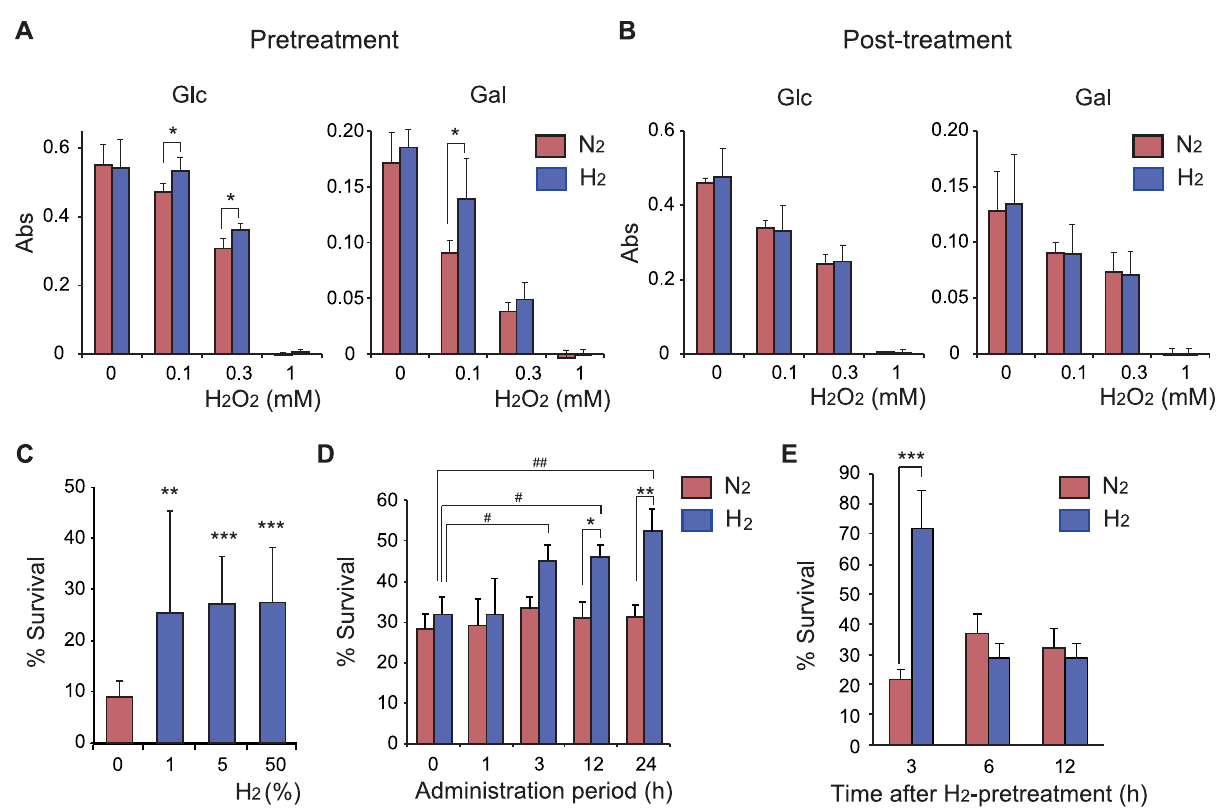
Fig 2. Protective effect of H 2 pretreatment against H 2 O 2 -induced cell death. (A) For pretreatment with mixed gas, SH-SY5Y cells were incubatedin culture medium containingeither Glc or Gal under N 2 - or H 2 -mixed gas for 18 h. Immediately after the end of exposureto the mixed gas, the medium was replaced with fresh medium containingthe indicatedconcentration of H 2 O 2 . Cells were further incubatedin a conventional CO 2 incubatorfor 18 h. (B) For post-treatment with mixed gases, culture medium containingeither Glc or Gal was replaced with fresh medium containingthe indicatedconcentration of H 2 O 2 . Cells were further incubatedunder an appropriate mixed gas. After the final incubation,cell viability was estimated by a modified3-(4,5-dimethylthiazol-2-yl)-2,5-diphenyltetrasodium bromide viabilityassay (A, B). (C) The protective effects of pretreatment with mixed gas containing different concentrations of H 2 against0.5 mM H 2 O 2 -induced cell death were examined.(D) The protective effects of pretreatment with N 2 - or H 2 -mixed gas for different durationsagainst0.5 mM H 2 O 2 - inducedcell death were examined.Applying two-way ANOVA showedsignificanteffects of mixed gas ( P = 0.0017) and duration ( P = 0.0315), howeverno interaction betweenthem was observed( P = 0.2224). (E) After pretreatment with N 2 - or H 2 -mixed gas, culture medium was replacedwith fresh medium, cells were incubatedin a conventional CO 2 incubatorfor the indicatedduration, and then H 2 O 2 (final 0.5mM) was added.Cells were further incubatedfor 18 h. All cells used in C—E were cultured in medium containing Glc. After the final incubation,cell viability was estimated by a two-colorfluorescence cell viabilityassay and expressedas a percentagecomparedwith cells not treated with H 2 O 2 (consideredas 100%) (C—E). * P < 0.05, ** P < 0.01, *** P < 0.001 versus treatment with N 2 -mixed gas. # P < 0.05, ## P < 0.01 versus an administration periodof 0